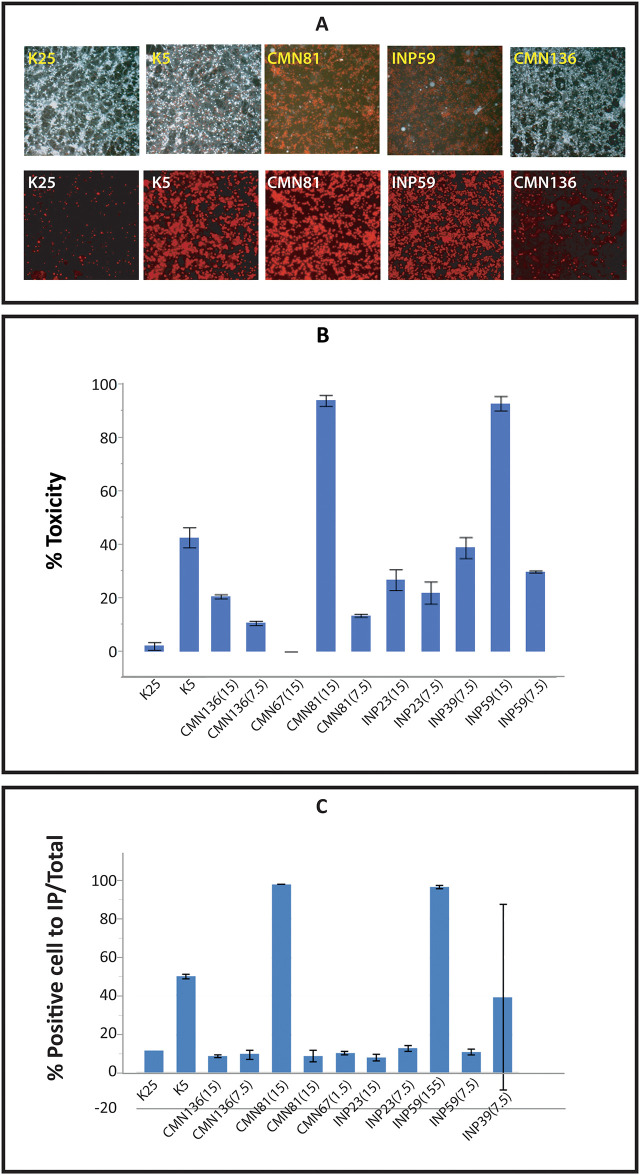
A. Neurotoxicity of RIAO from representative PTS of sera of patients and controls. Dose-dependent (7.5 = 0.029 mg/ml and 15 = 0.059 mg/ml) toxicity effects of RIAO on cerebellar granule cells (NGCs) as measured by the calcein-AM method. K25 is considered the optimal condition for NGC survival, while K5 induces more than 50% cellular death after 24 h. Codes of samples: CMN81:obesity; INP59:T1DM; CMN136:healthy child. B. Neurotoxicity of RIAO from representative PTS of patients and controls. Dose-dependent (7.5 = 0.029 mg/ml and 15 = 0.059 mg/ml) toxicity effects of RIAO on cerebellar granule cells (NGC) as measured by MTT. C. Neurotoxicity of RIAO from representative PTS of patients and controls. Dose-dependent (7.5 = 0.029 mg/ml and 15 = 0.059 mg/ml) toxicity effects of RIAO on cerebellar granule cells (NGC) as measured by calcein-AM methods. K25 is considered the optimal condition for NGC survival, while K5 induces more than 50% of cellular death after 24 h. Codes of samples: CMN136:healthy child; CMN81:obesity; CMN67:; INP23:T1DM; INP59: T1DM; INP39:T1DM.